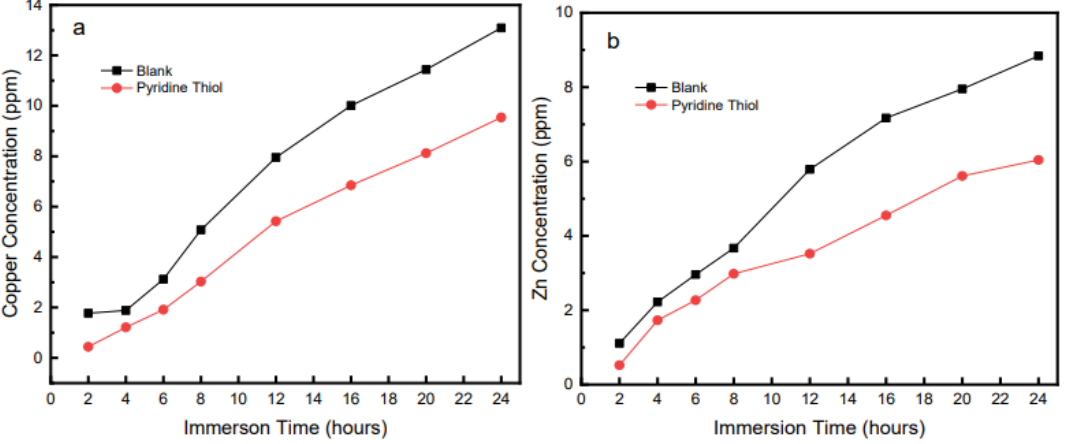
Figure 2. Copper ( a ) and Zinc ( b ) concentration (ppm) present in 0.5 M H 2 SO 4 solution with time for 0.5 mM P2T obtained by atomic adsorption spectroscopy measurements.